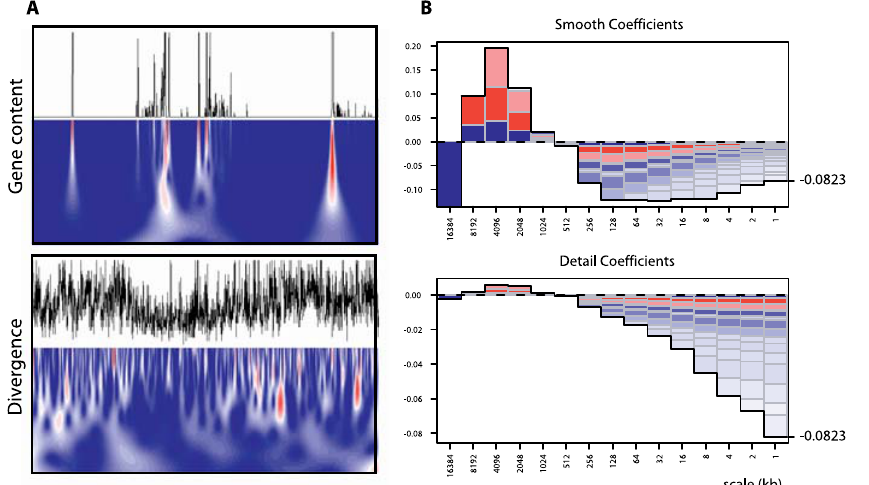
Figure 1. Wavelet Transformation of Genome Annotations (A) To illustrate the purpose of wavelet transformation, we show the original traces and continuous wavelet transformations using the derivative of Gaussian wavelet basis for gene content and divergence over a 2-Mb stretch of Chromosome 20. Colours indicate the magnitude (blue ¼ low, red ¼ high, white ¼ zero) of the wavelet coefficients at each scale and location, with each level being normalised to have equal variance. (B) Analysis of the correlation between the smoothed and detailed coefficients at each scale (see Text S2). The height of each bar is the value of the correlation coefficient and the boxes are the contributions from broader scales (top is the broadest scale), with colour intensity related to the magnitude of the effect (blue is negative, red is positive) and size proportional to the fraction of variance explained by a given level. The correlation between divergence and constraint in the original signal ( (cid:1) 0.0823) can be decomposed into positive contributions from correlations between detail coefficients at broad scales and negative contributions from correlations between detail coefficients at fine scales. DOI: